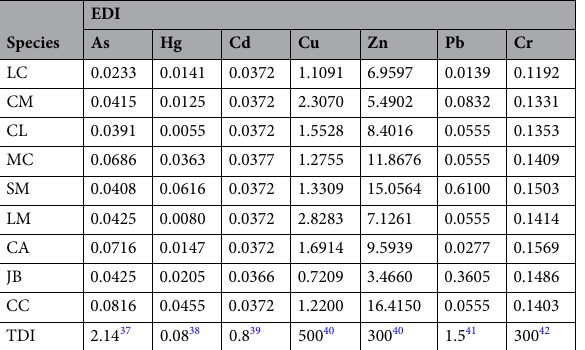
Table 4. Estimated daily intake (EDI) established for the consumption of fish from Dachen fishing ground, East China Sea (units ug/kg bw/day for EDI and TDI, ww).